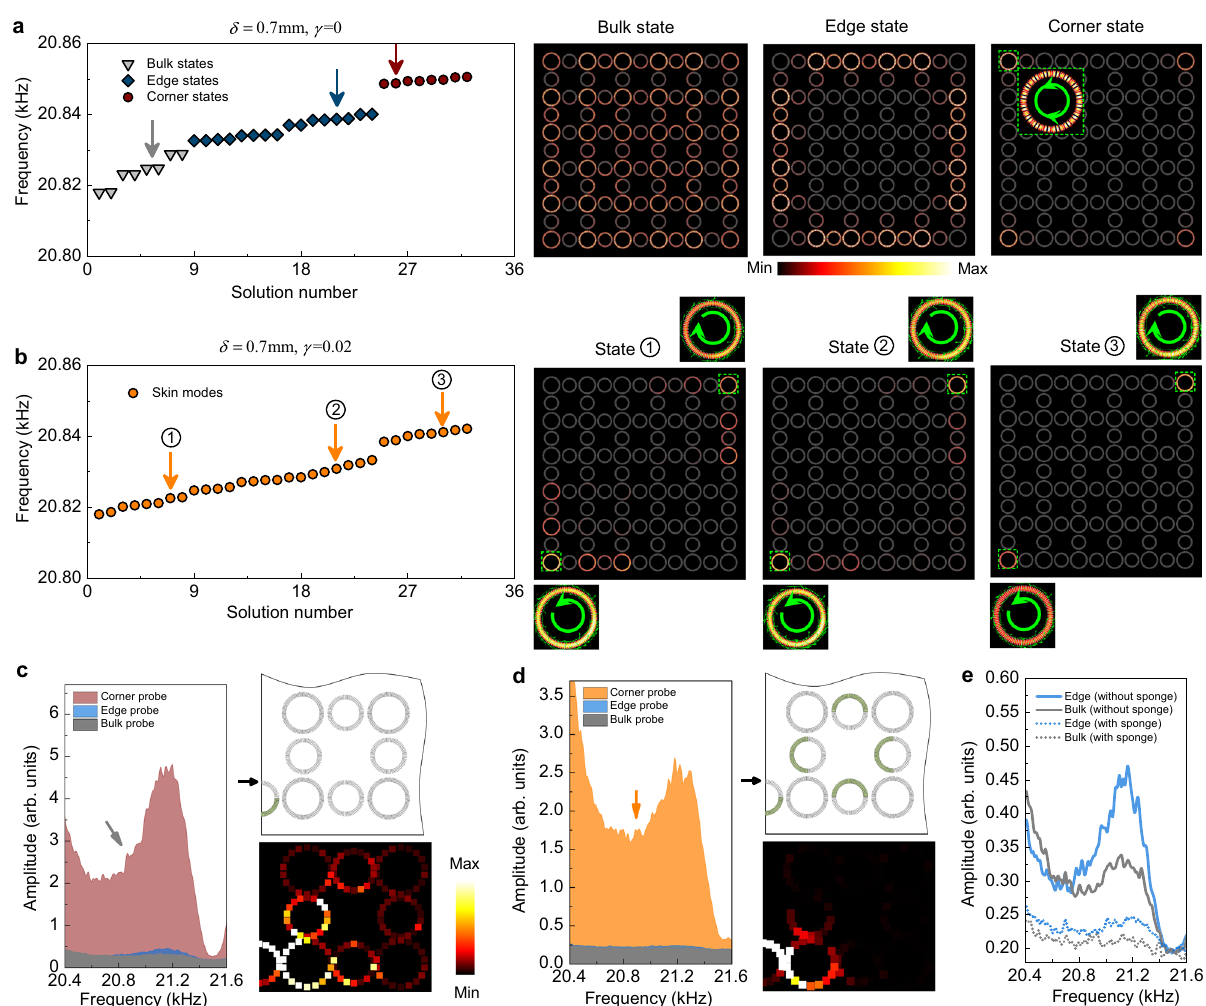
Fig. 3 Higher-order non-Hermitian skin effect. a Calculated eigen-spectrum for a box-shaped SC (in the Hermitian regime) with OBC in both the x and y directions. There are eight corner states (dark red), sixteen edge states (dark blue), and eight bulk states (gray). The corresponding acoustic wavefunctions for the bulk, edge, and corner states (marked by arrows) are presented. b The same as a , but with acoustic loss. The higher-order non-Hermitian skin effect is manifested by the emergence of spin-polarized, corner-like skin-modes. Depending on the spin-polarizations, the corner-like skin modes reside near the lower-left (for spin-up modes) and upper-right (for spin-down modes) corners. c – e Experimental demonstration of the higher-order non-Hermitian skin effect. Both the transmission spectra (for the bulk, edge, and corner pump-probes) and the scanned acoustic pressure pro fi les are presented, which show consistency with